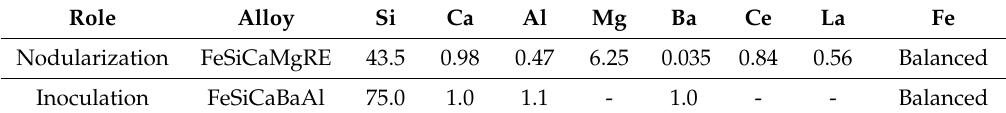
Table 1. FeSi-based alloys for nodularization and inoculation (wt.%).